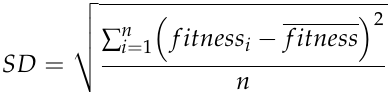
Table 3. The t ‐ test of standard deviation of population in different generations using BBA CO and BBA LHS .